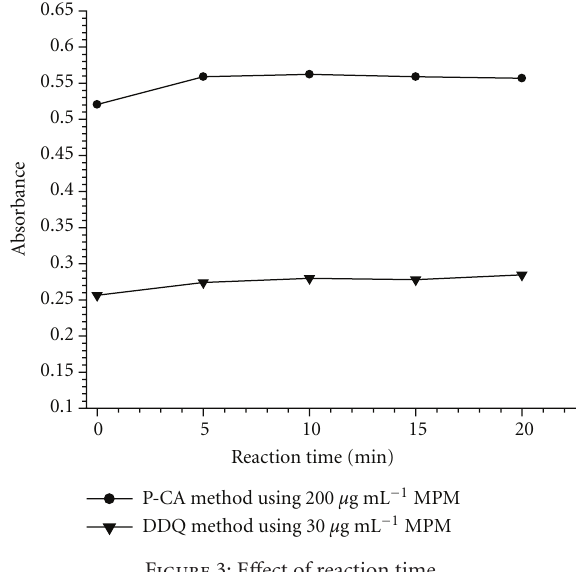
Figure 3: E ff ect of reaction time. Table 4: Results of analysis of CellCept 500 tablets Ψ by the proposed methods and statistical comparison of the results with the reference method.